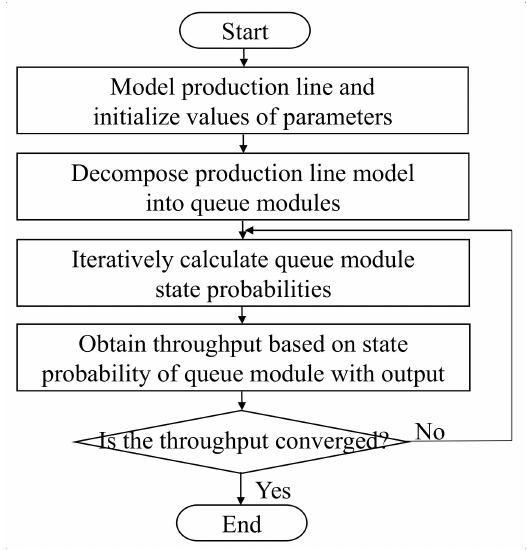
Figure 3. Framework of QMTAA.